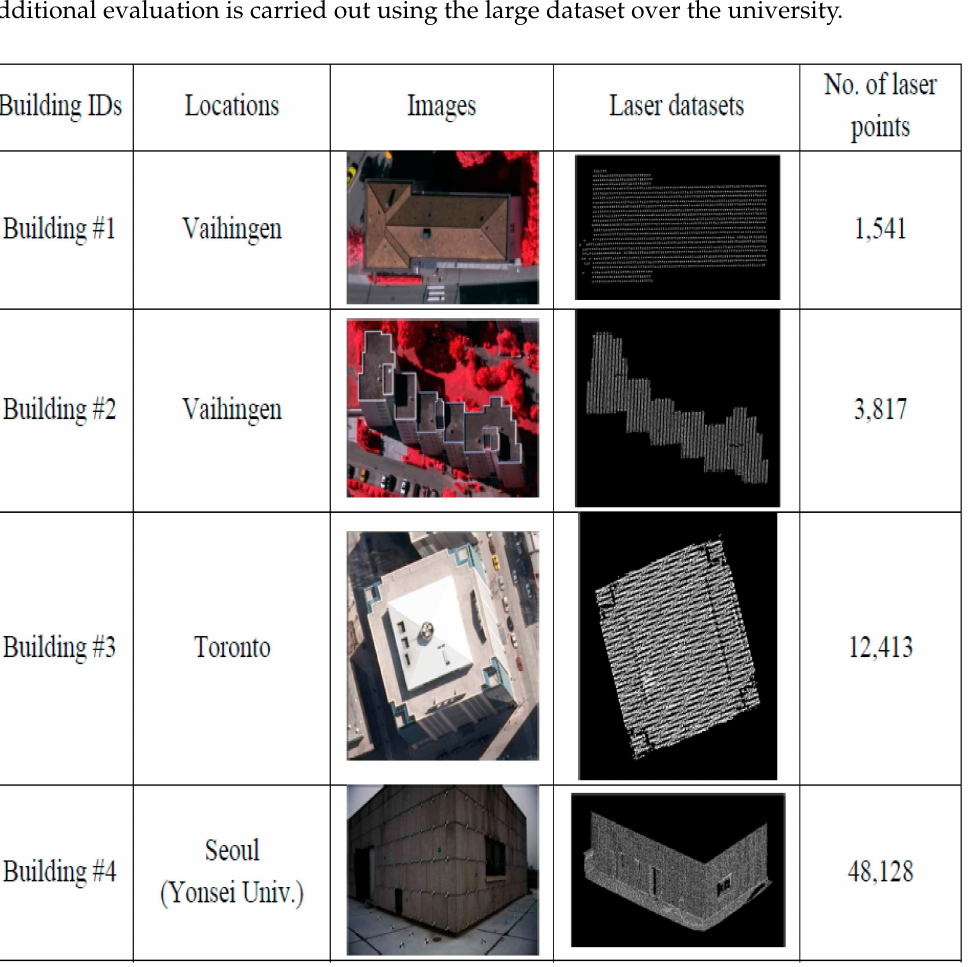
Figure 14. Optical images and displayed laser data of four